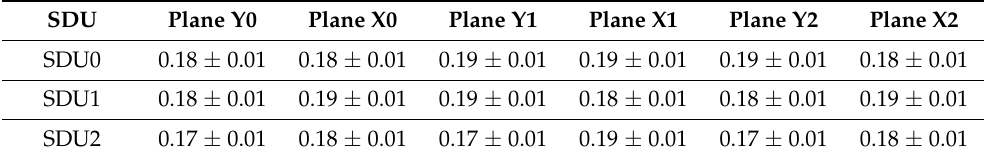
Table 2. The same as Table 1, but from the calibration campaigns performed at GSI-Darmstadt in November 2003 and April